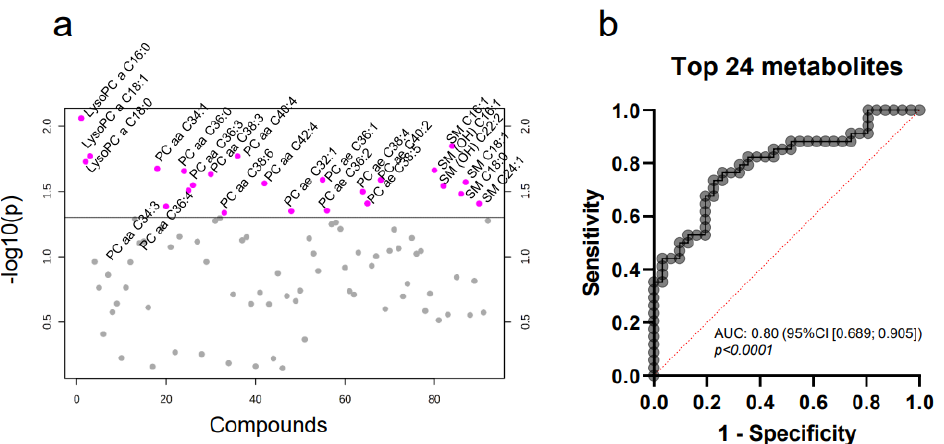
Figure 4. MV-based metabolomics allows the differentiation between molecular breast cancer sub- types. The metabolomic profiles of plasma MV from luminal A and luminal B breast cancer patients were compared by targeted mass spectrometry. t-statistics ( a ) reveal 24 significantly differentially expressed metabolites (unpaired Student’s t-test, relevant metabolites colored in pink). Multiple logistic regression ( b ) for combined ROC analysis of all 24 metabolites.